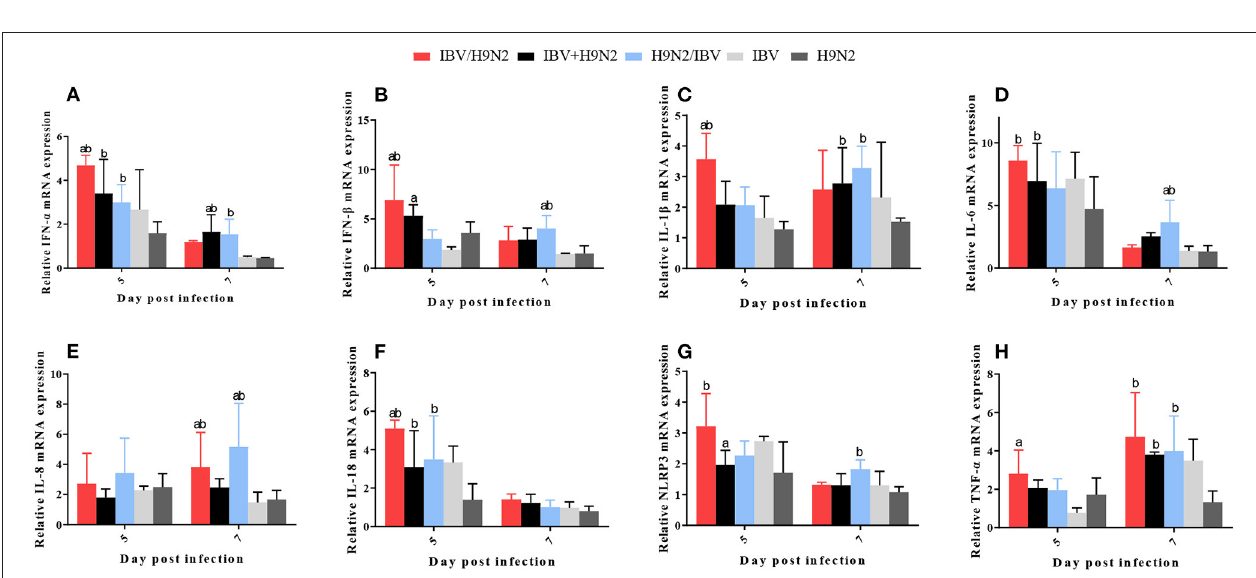
FIGURE 10 | Effect of co-infection with IBV and H9N2 virus on inflammatory cytokines in the lungs. (A) IFN- α , (B) IFN- β , (C) IL-1 β , (D) IL-6, (E) IL-8, (F) IL-18, (G) NLRP3, and (H) TNF- α . Data are presented as means ± SD. “a” indicates a significant difference ( P < 0.05) between the three co-infection groups and the IBV group. “b” indicates a significant difference ( P < 0.05) between the three co-infection groups and the H9N2 group. “ab” indicates a significant difference ( P < 0.05) between the three co-infection groups and the H9N2 group. IBV, infectious bronchitis virus; IFN, interferon; IL, interleukin; NLRP3, NLR family pyrin domain containing 3; TNF- α , tumor necrosis factor- α ; SD, standard